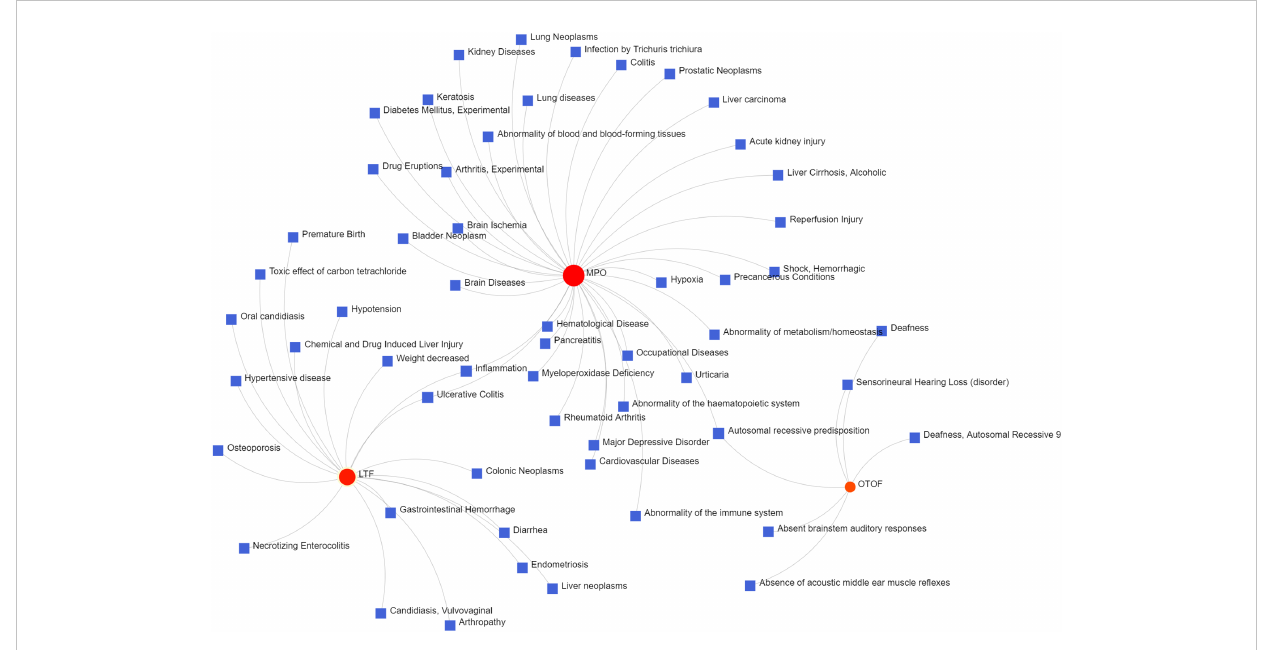
FIGURE 7 The gene-disease association network represents diseases associated with mutual